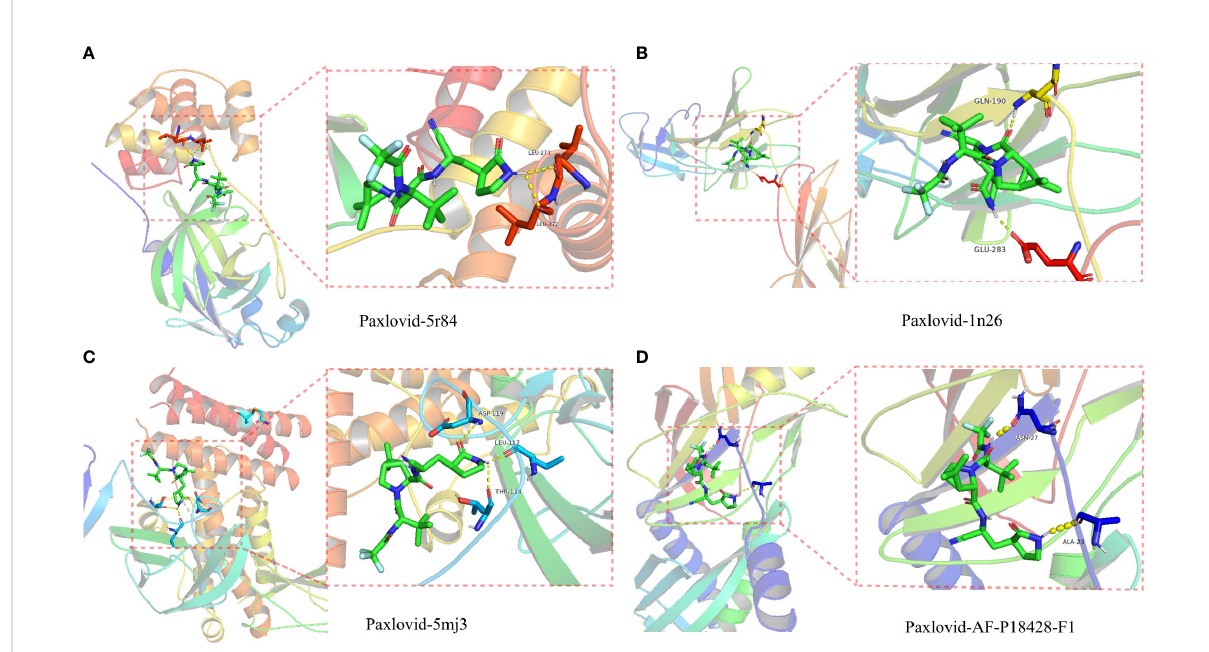
FIGURE 8 Binding of Paxlovid to COVID-19 and the core target IL6, IL12B and LBP using molecular docking analysis. (A) Hydorgen bond formed between niacin and 5R84 protein of COVID-19 on LEU-271, LEU-272. (B) Hydorgen bond formed between Paxlovid and 1N26 protein of COVID-19 on GLN-190, GLU-283. (C) Hydorgen bond formed between Paxlovid and 5mj3 protein of COVID-19 on ASP-119, LEU-117 and THR-114. (D) Hydorgen bond formed between Paxlovid and AF-P18428-F1 protein ofCOVID-19 on ASN-27 and